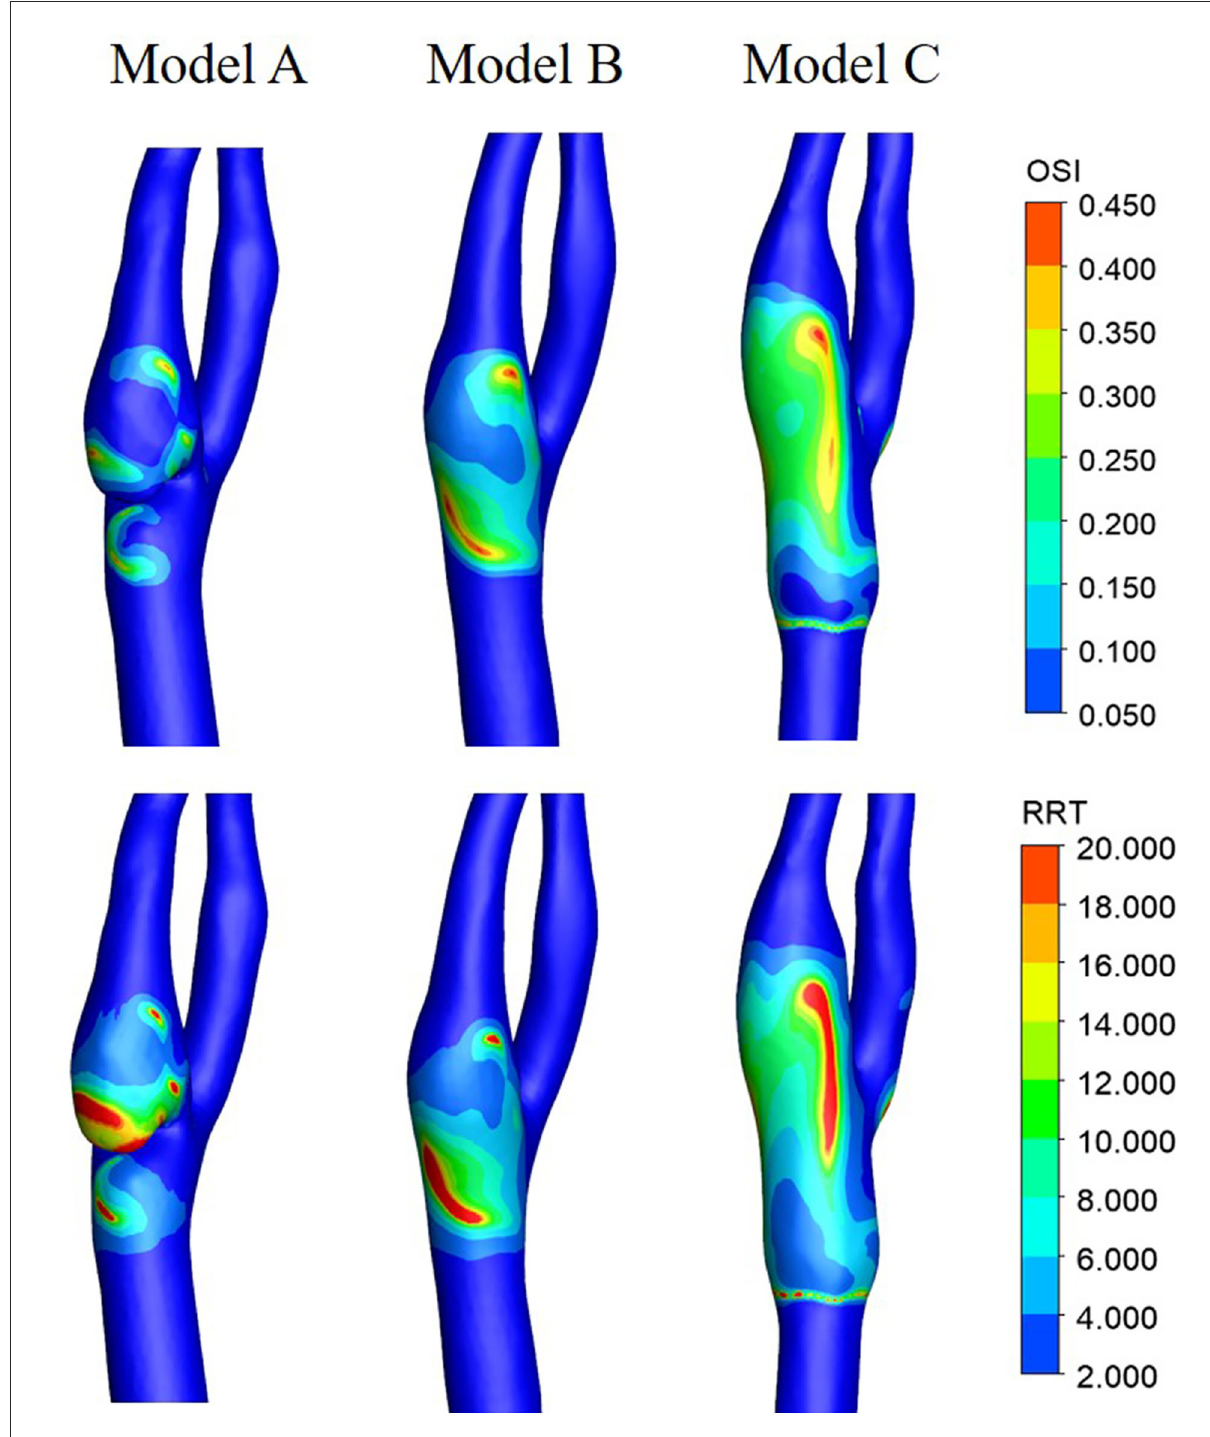
FIGURE8 Contours of OSI and